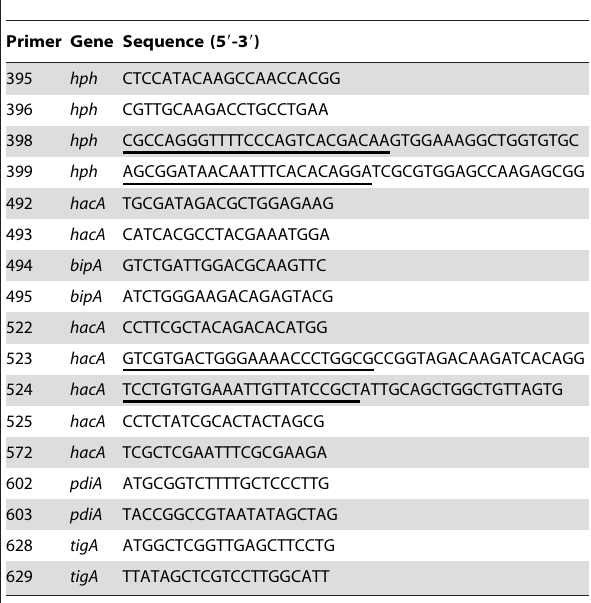
Table 3. PCR primers used in this study. M13-derived sequences used for overlap PCR are underlined